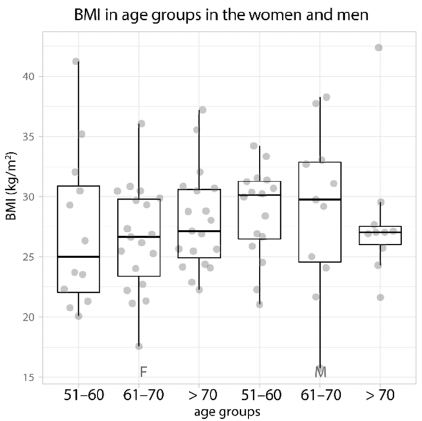
Figure 4. Data distribution (jittered dots) and boxplot of the median BMI (kg/m 2 ) in the age groups in the women and men. The data are ordered according to their median value. F—female, M—male.